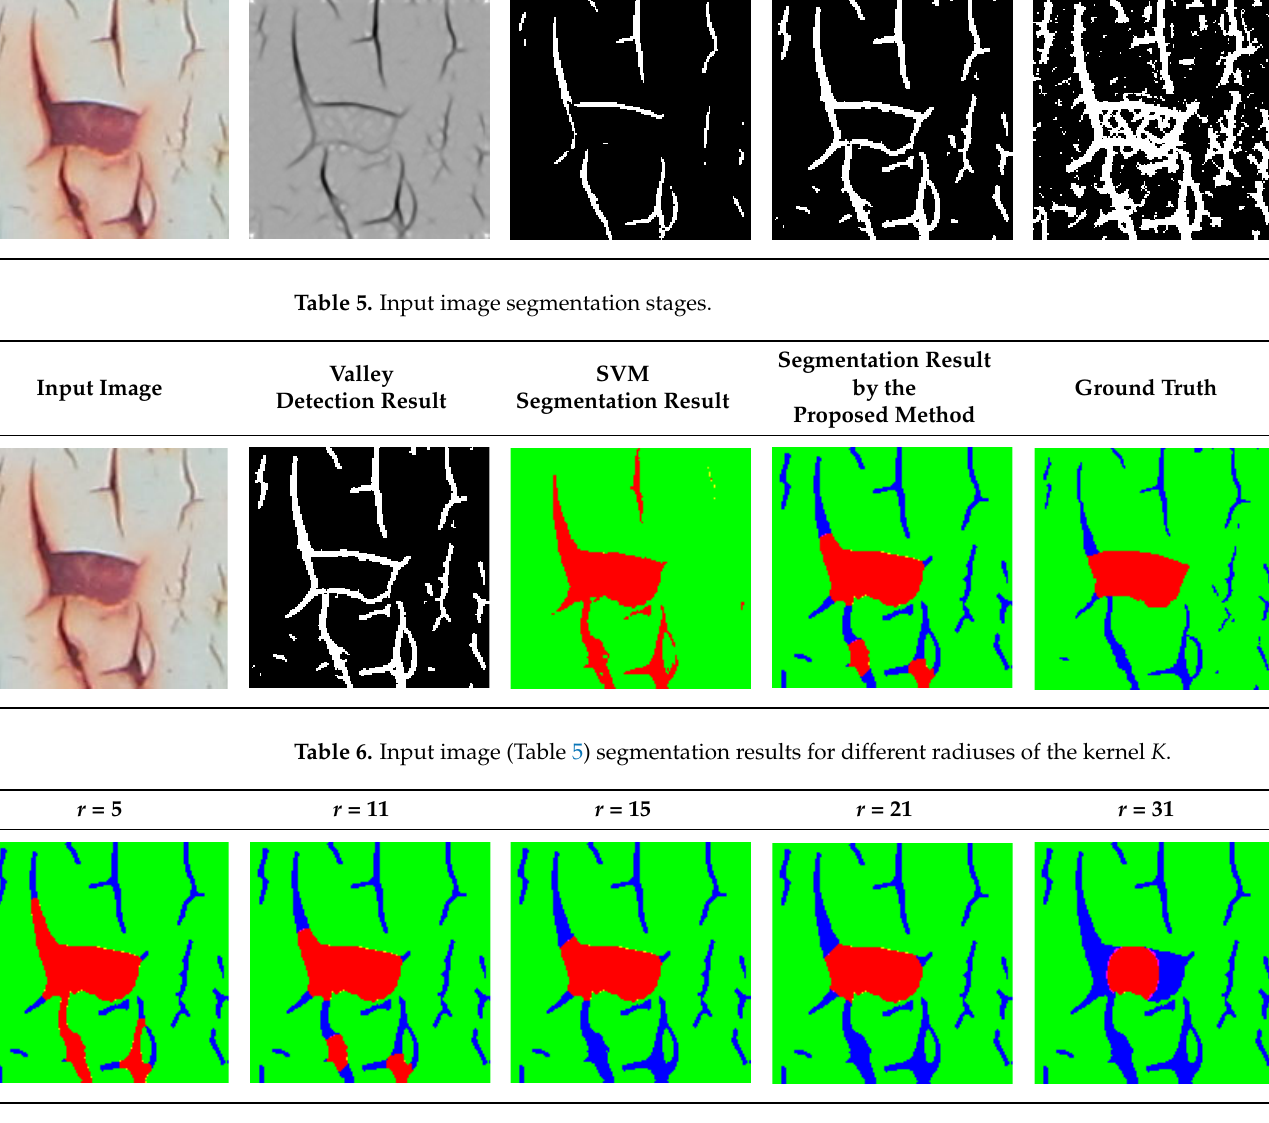
Table 6. Input image (Table 5) segmentation results for different radiuses of the kernel K . 5 r